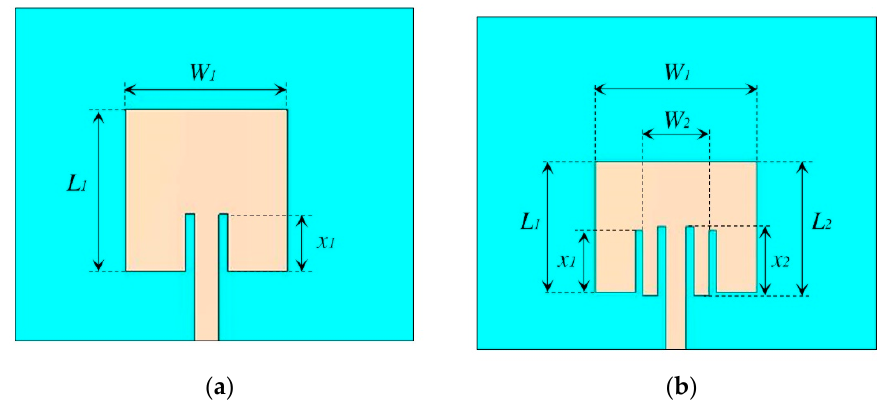
Figure 1. Microstrip patch antenna configurations: ( a ) MPA1, ( b ) MPA2. Geometrical parameters for MPA1 and MPA2 are listed in Table 1. For manufacturing